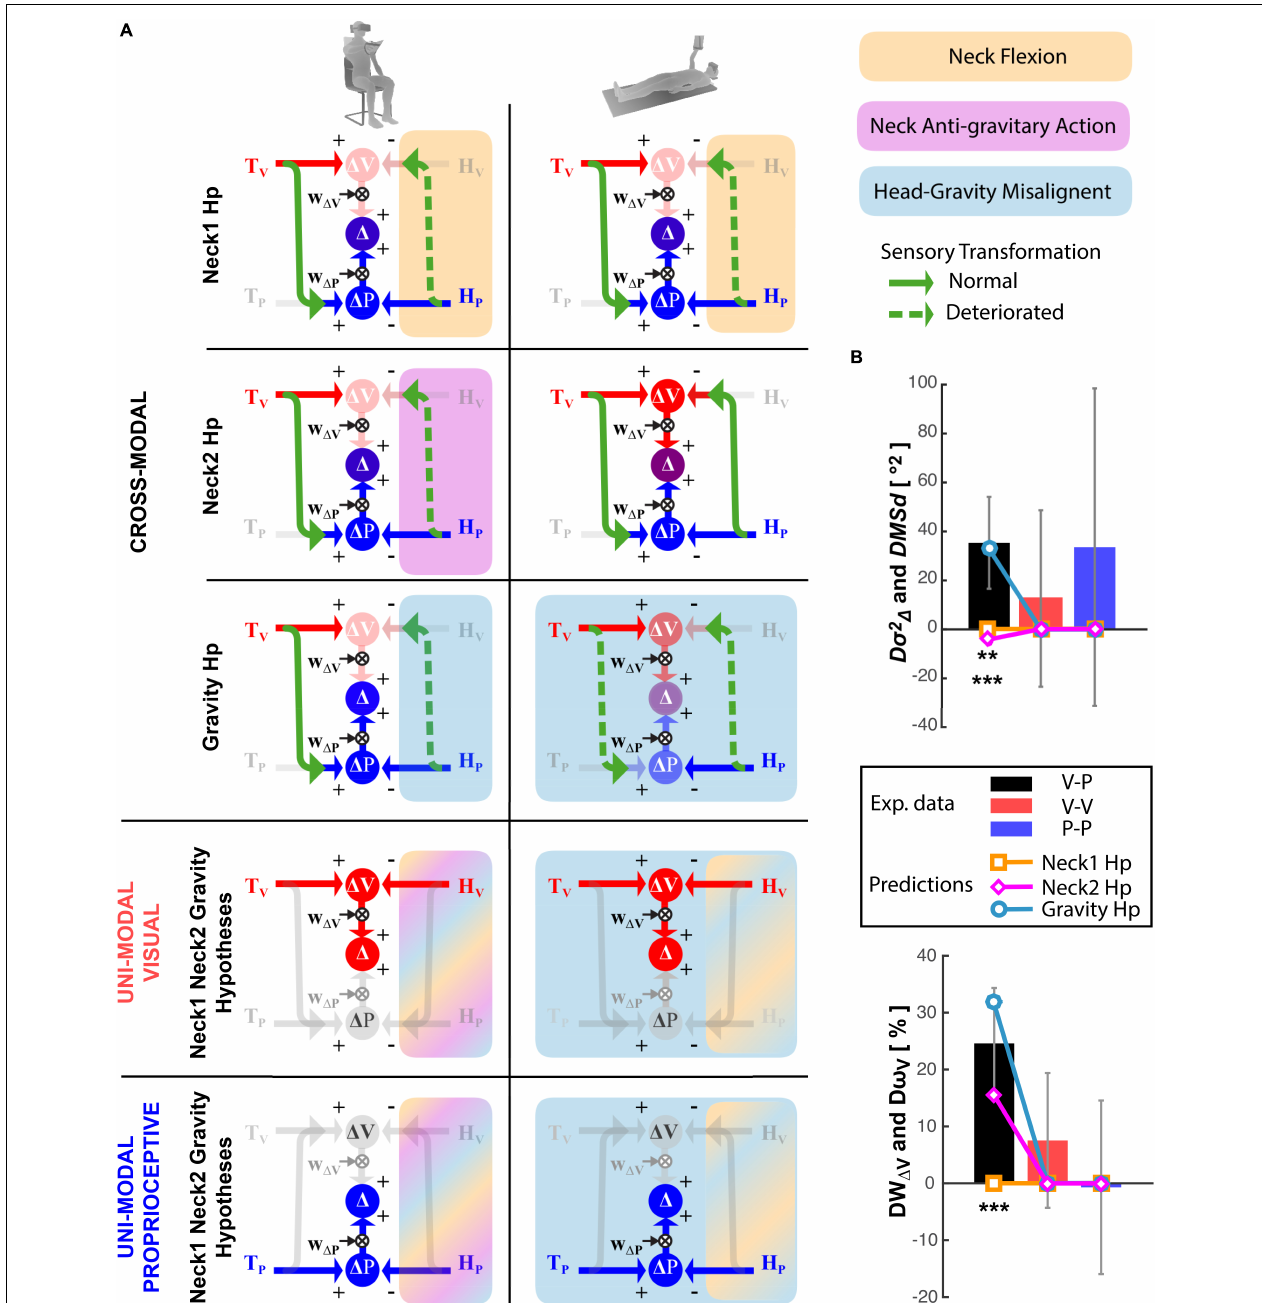
FIGURE 7 | Model predictions. (A) Graphical representation of the sensory information flow in the Seated (left) and Supine (right) conditions for the cross-modal, unimodal visual and unimodal proprioceptive experiments. For the cross-modal task the predictions for the Neck1, Neck2, and Gravity hypotheses are represented separately. For the unimodal visual and proprioceptive tasks, the three hypotheses are identical and thus represented together. The model structures and the graphical conventions are the same as in Figure 3 . In addition, dashed green arrows represent perturbed cross-modal sensory transformations; faded arrows and circles are associated with a noisy information. For each tested theory the colored rectangular areas include the cross-modal transformations perturbed by the hypothesized disrupting factor: orange, violet and cyan represent the neck flexion, the neck muscles action against gravity and the head-gravity misalignment, respectively. Since for the unimodal tasks the three hypotheses are represented together, multicolor areas illustrate the cross-modal transformations affected by more the one disrupting factor. (B) Comparison between the experimental results and the predictions of the three hypotheses, in terms of modulation of the response variance (upper panel) and visual weight (lower panel) due to postural change (Supine-Seated). Vertical whiskers represent the 95% confidence interval of the experimental data. ** and *** represent statistical difference ( p < 0.01 and p < 0.001) between the model predictions and the experiments results for each experiment and each parameter separately. The color of the stars indicates the tested